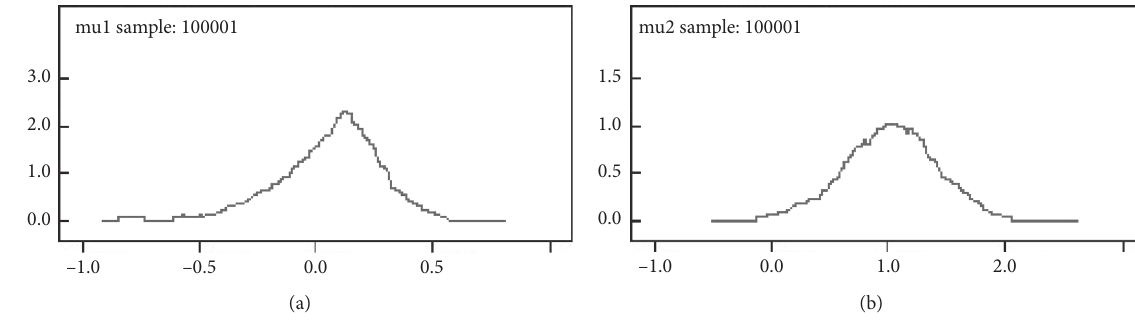
Figure 1: μ sp and μ sh posterior distribution Table 3: Volatility spillover parameter estimation result.